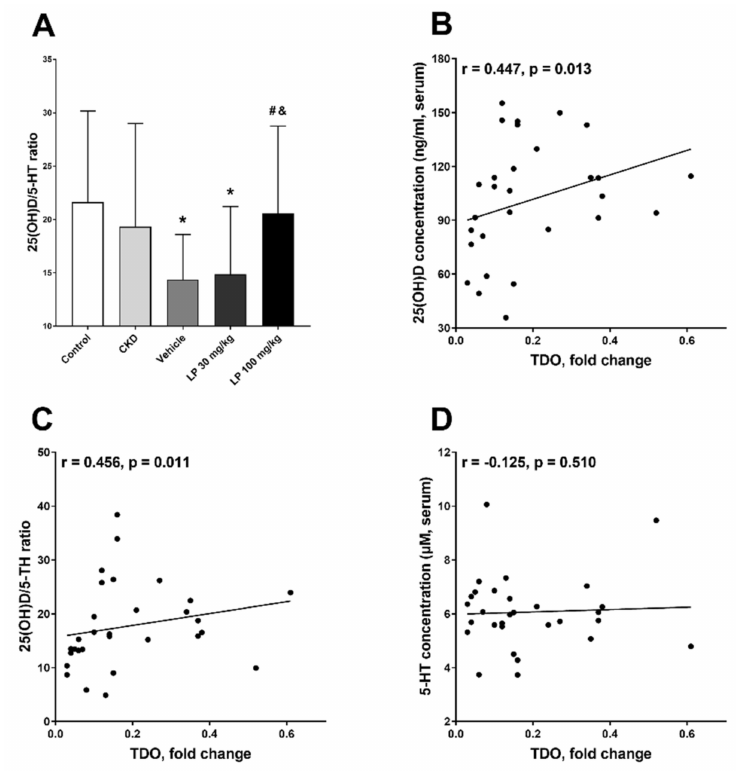
Figure 5. Changes in serum 25-hydroxyvitamin D to serotonin (25(OH)D / 5-HT) ratio ( A ) among experimental groups, and the association between bone tryptophan 2,3-dioxygenase (TDO) expression and serum 25(OH)D concentration ( B ), 25(OH)D / 5-HT ratio ( C ), and 5-HT level ( D ) in rats with CKD treated with LP533401. Data are shown as mean ± SD. * p < 0.05, control vs. others; # p < 0.05, vehicle vs. others; & p < 0.05, LP 30 mg / kg vs. LP 100 mg /